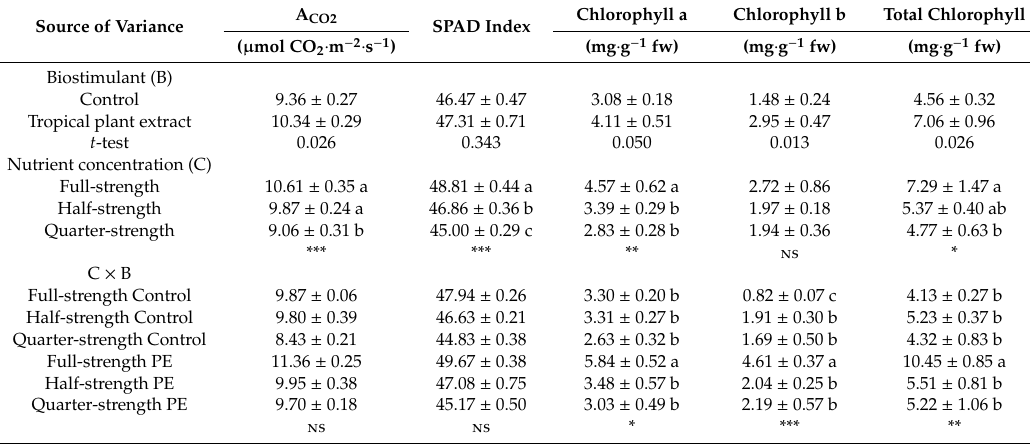
Table 3. Net CO 2 assimilation rate (A CO2 ), Soil Plant Analysis Development (SPAD) index, and chlorophyll content of hydroponically grown jute in relation to nutrient solution concentration and tropical plant extract biostimulant application. All data are expressed as mean ± error, n =